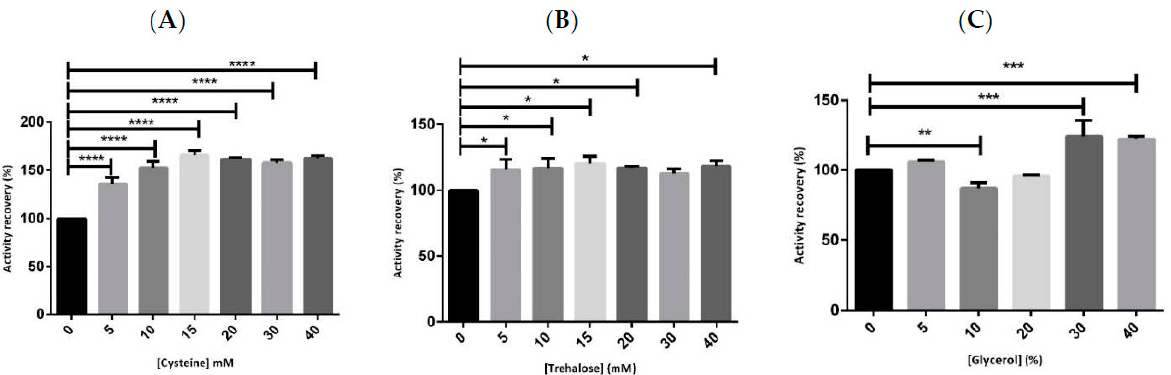
Figure 1. Graphical representation of hMBCOMT activity recovery without the addition of additives in comparison to hMBCOMT in contact with the additives: ( A ) Cysteine; ( B ) Trehalose; ( C ) Glycerol after 12 h at 4 °C. ( p -value * <0.05; ** <0.01; *** <0.001; **** <0.0001).